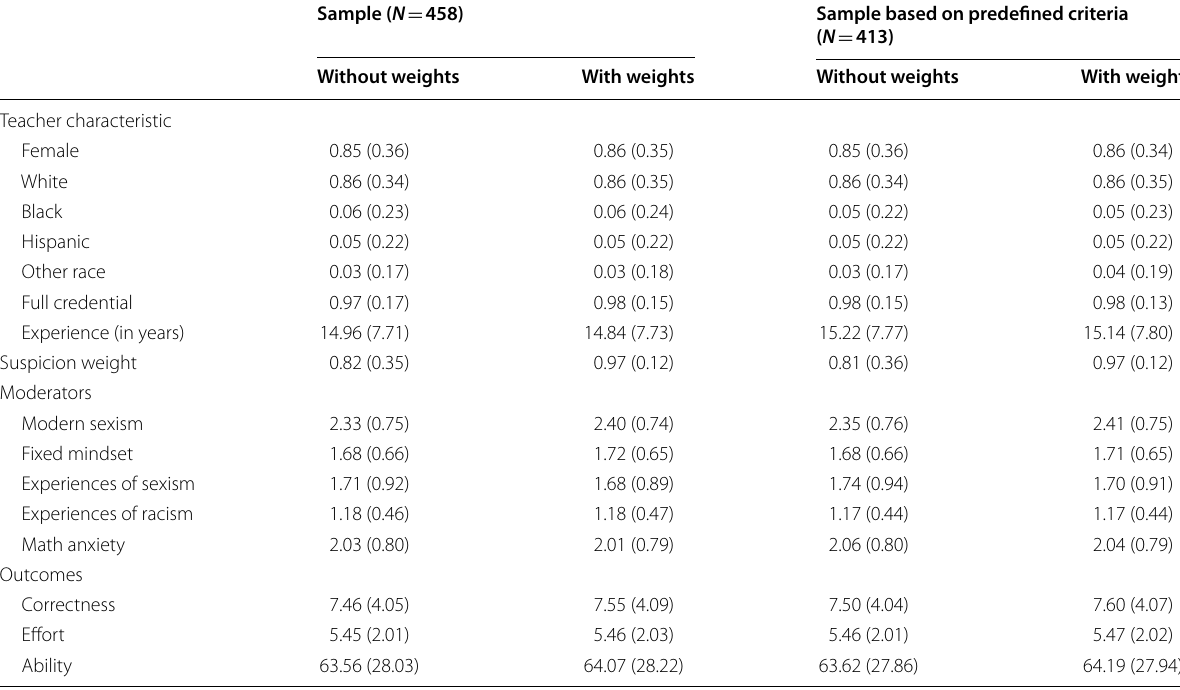
The values shown are means, followed by standard deviations in parentheses. The Other race category included teachers from other races, such as Asian, Native American, or two or more